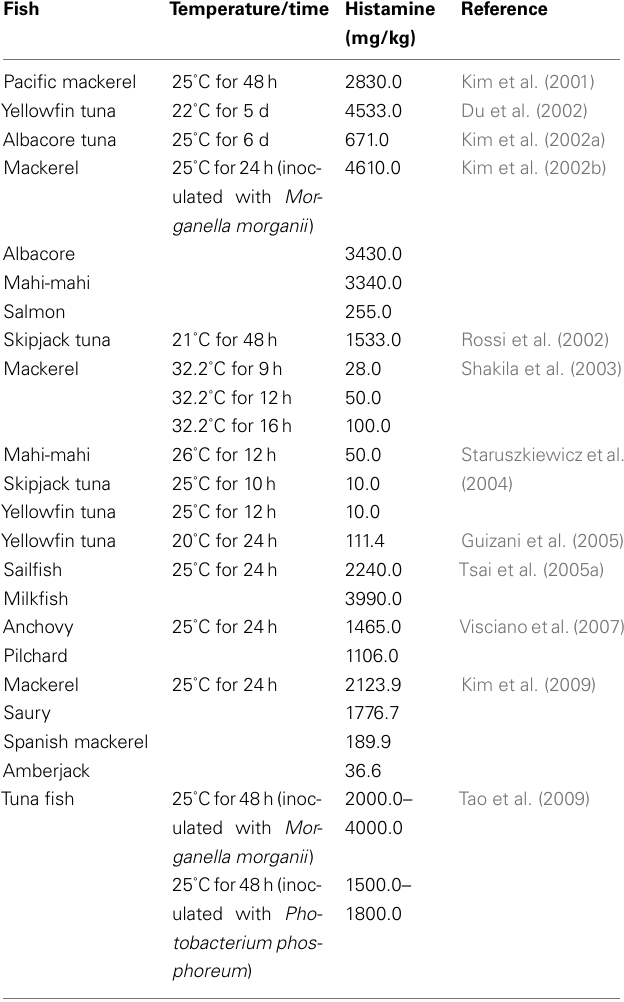
Table 1 | Histamine content in fresh fish stored at abused temperature/time conditions.